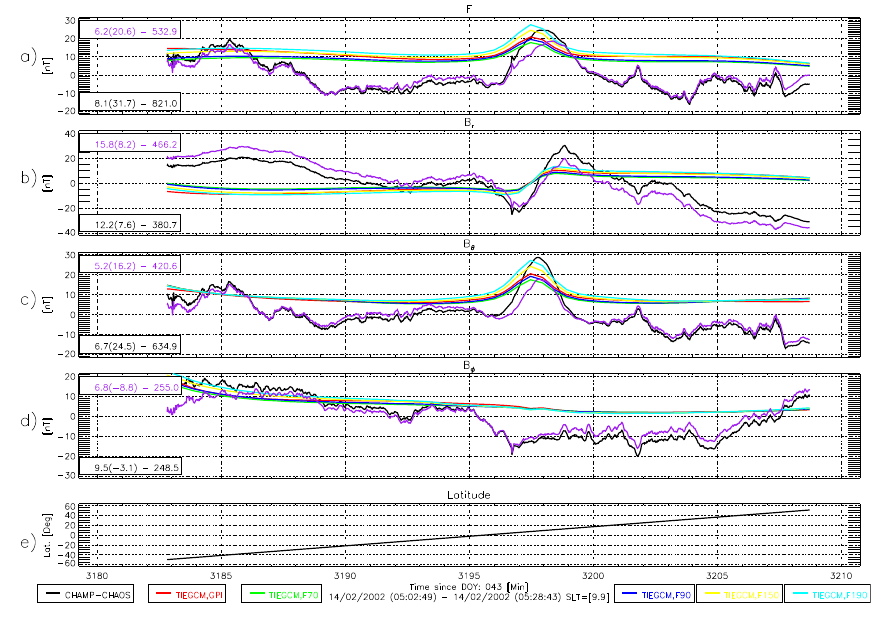
Fig. 4. The residual and TIE-GCM perturbation prediction data along the satellite orbit track for one orbit pass on 14 February 2002 between ± 50 ◦ latitude in units of nT. The bottom axis is time (minutes) since the start of the modeling run, in this case 12 February 2002. The plot windows correspond to (a) the total field perturbation, (b) the B r component of the perturbation, (c) the B θ component, (d) the B φ component, and (e) the satellite latitude. All five TIE-GCM model runs are shown vs. the CHAMP data and perturbation residuals using the following color scheme: F 10 . 7 =GPI (red), F 10 . 7 = 70 (green), F 10 . 7 = 90 (blue), F 10 . 7 = 150 (yellow), F 10 . 7 = 190 (cyan), CHAMP/CHAOS residual (black), and CHAMP/CHAOS/TIE-GCM(GPI) residual